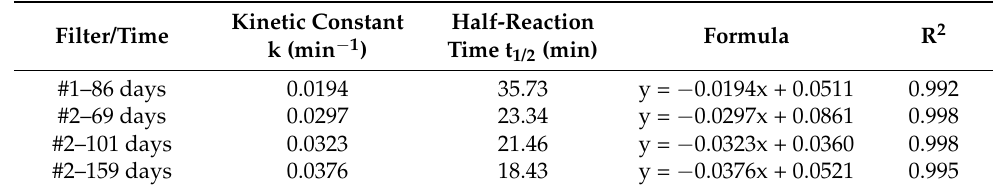
Table 3. Linear regression analysis of biological COD Mn removal at different